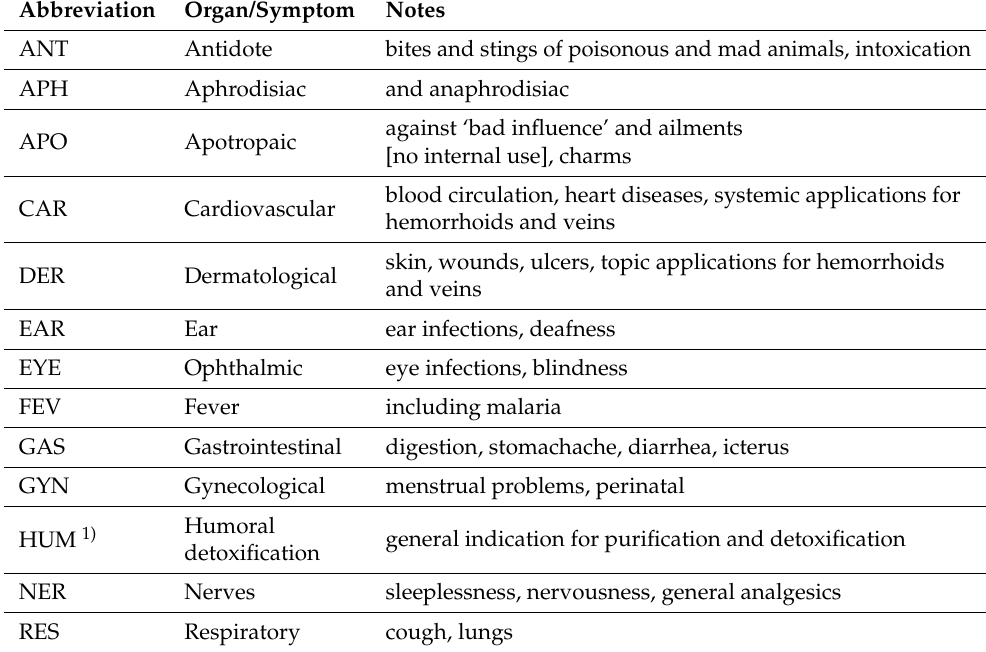
Table 2. Use categories related to organs and